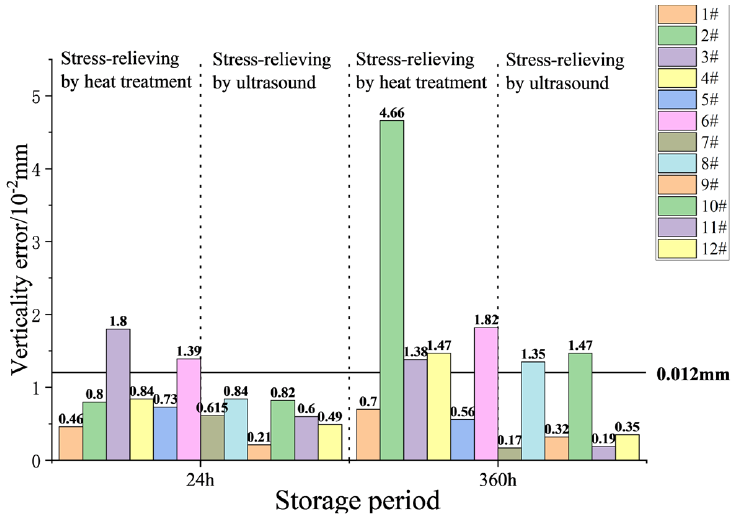
Figure 10. Comparison of verticality geometrical stability.